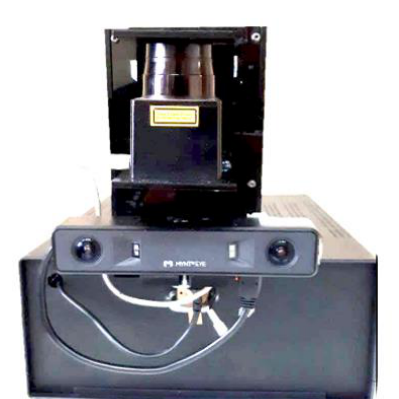
Figure 4. The integrated sensor is composed of a 2D LRF, a stereo camera, and a servomotor